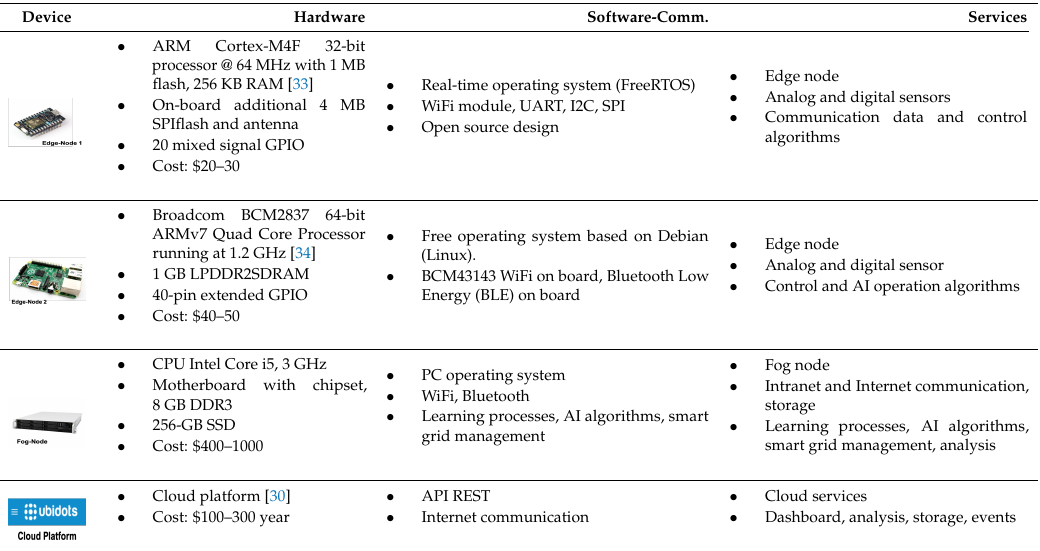
Table 1. Device list and